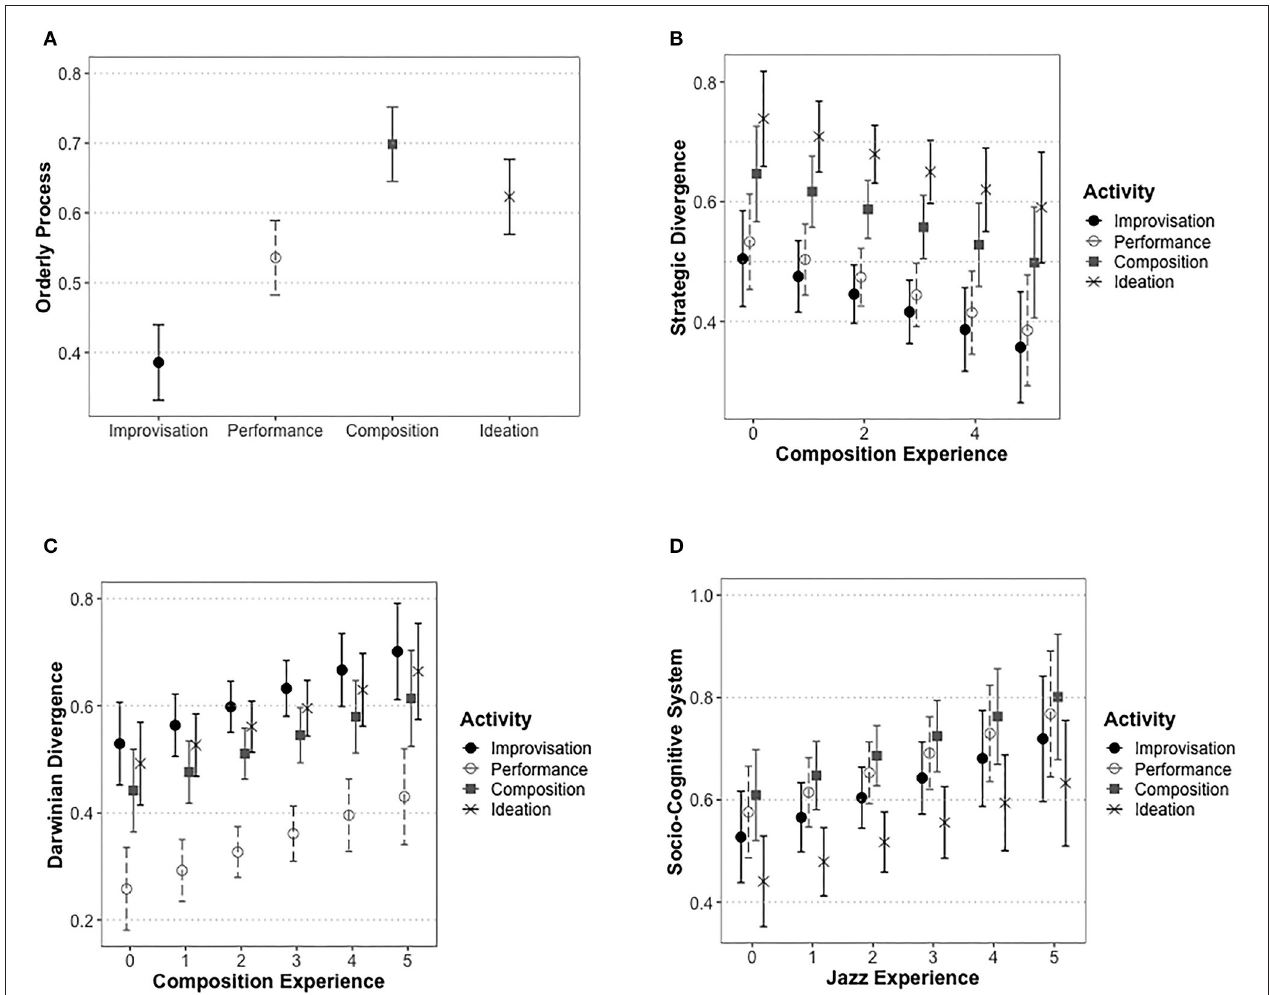
FIGURE 2 | Appreciation of the four theoretical dimensions: predicted values from linear mixed models (with 95% CIs). (A) Orderly Process. (B) Strategic Divergence. (C) Darwinian Divergence. (D) Socio-Cognitive